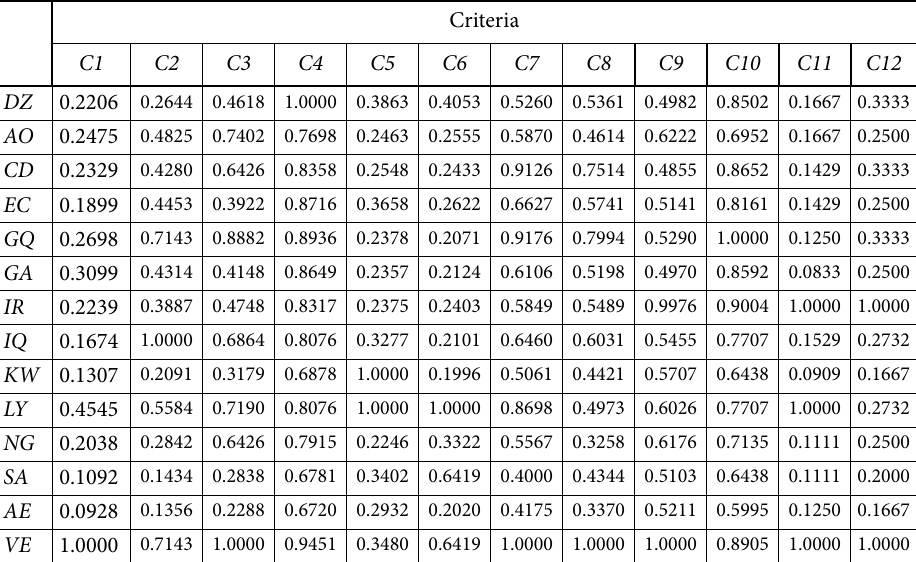
Table 2. Normalized decision matrix